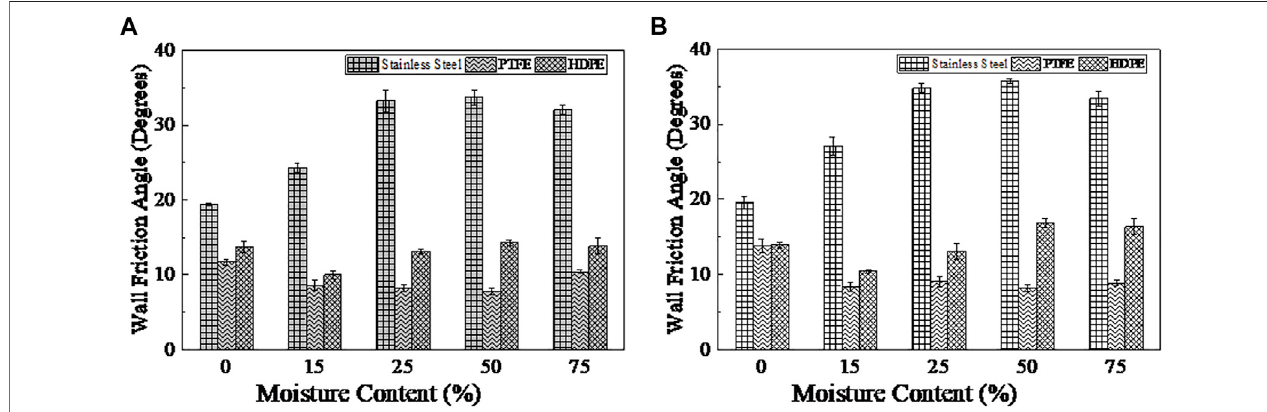
FIGURE8| Thewallfrictionanglesofthe (A) A and (B) B samples,with0,15,25,50,and75%moisturecontentsonstainlesssteel,PTFEandHDPEsurfaces.The R a valueofthestainless-steelsurfaceis1.2 µm.TheR a ofthePTFEdiskis0.48 µminthe X directionand0.48 µminthe Y -direction.TheR a oftheHDPEdiskis0.094 µm in the X direction and 0.107 µm in the Y -direction.